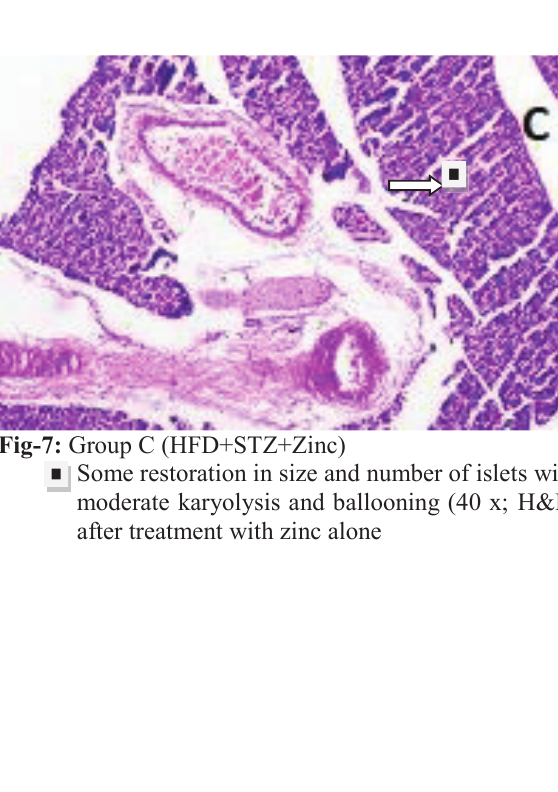
Fig-9: Group E (HFD+STZ+Zinc+full Cana) Restoration of size and number of islets with mild karyolysis and ballooning (40x; H&E)